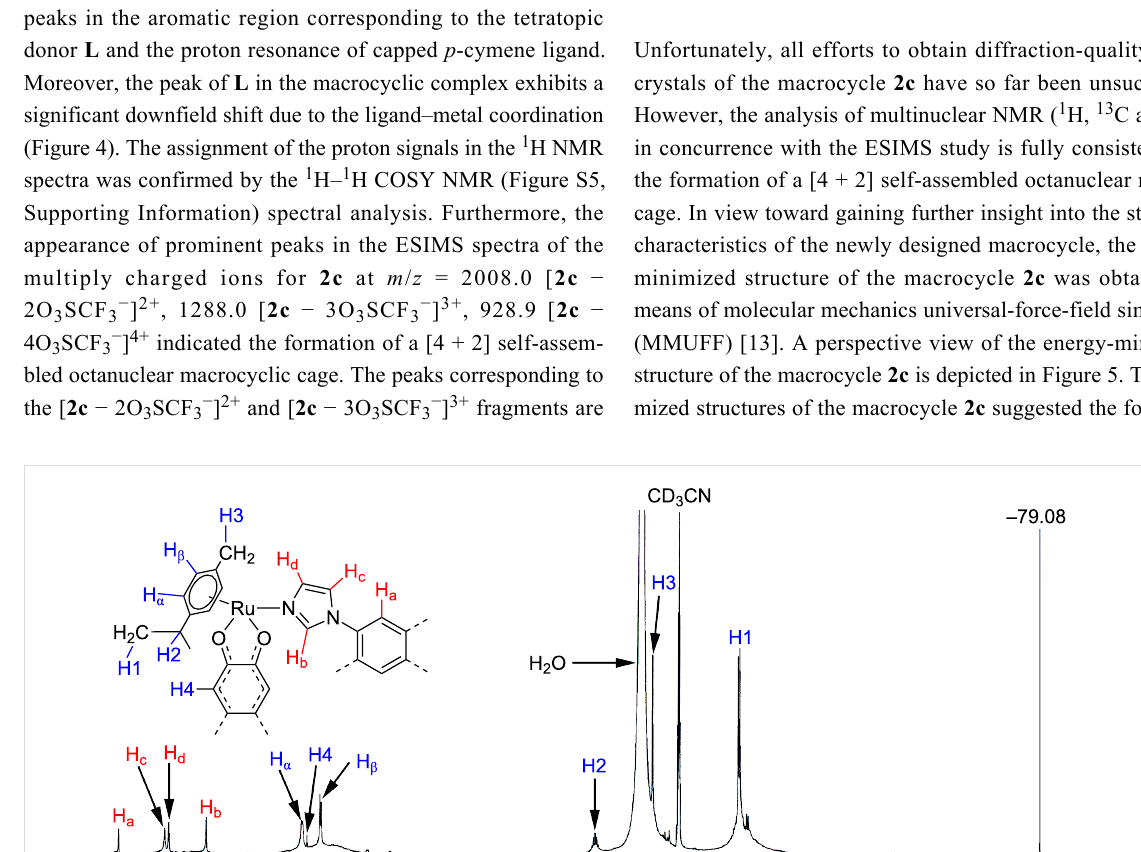
1515.8 cm − 1 ) due to the ligand-to-metal coordination. The 1 H NMR spectra of the macrocycle 2c established the